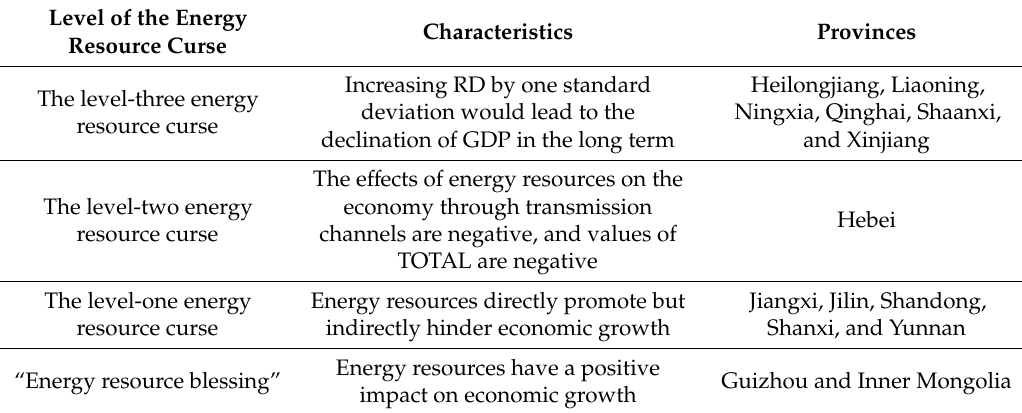
Table 8. Energy resource curse level and corresponding